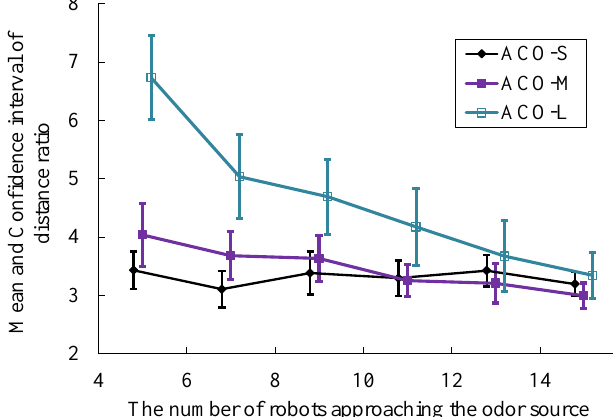
Figure 22. The mean and confidence interval of the distance ratio for different group size in the slightly wandering, medium-wandering and greatly wandering plume